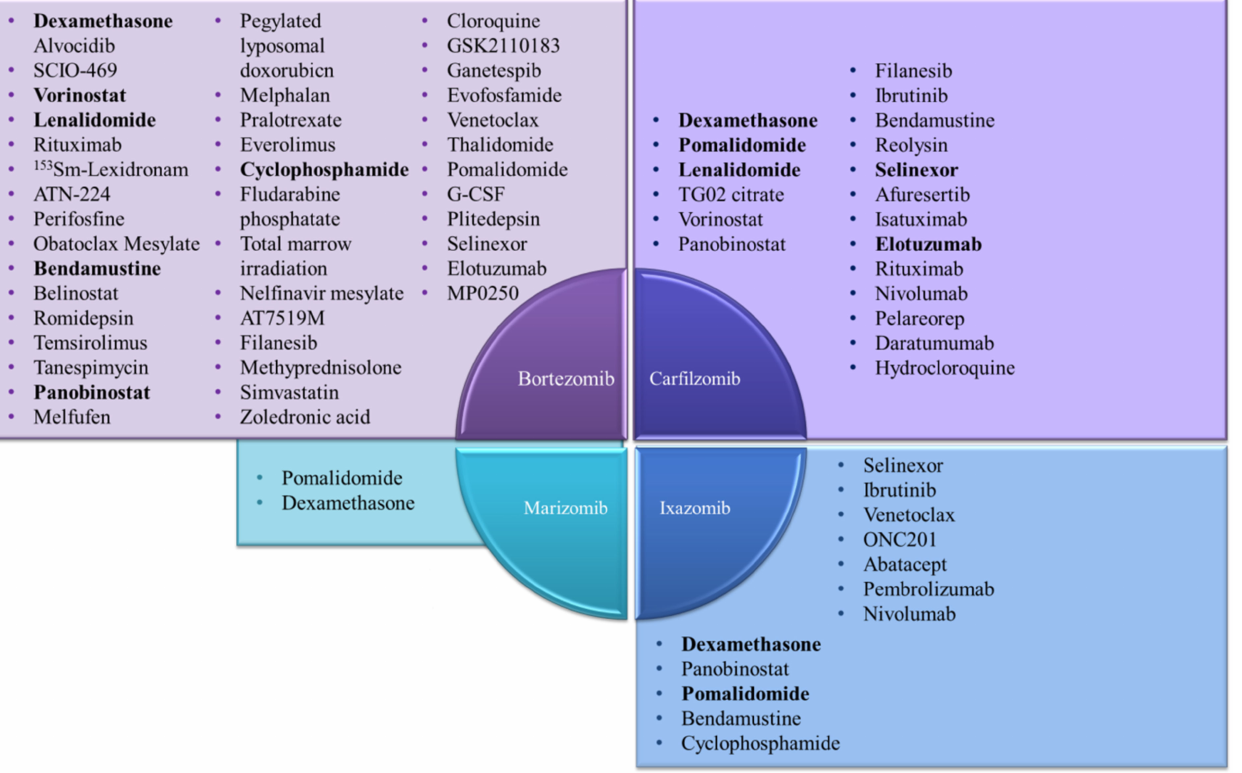
Figure 21. Combination therapies with 20S CP inhibitors in clinical trials, involving patients with relapsed and/or refractory disease, and who were previously treated with a 20S CP inhibitor (bold drugs are most frequently involved in combination therapy). Clinical trials were selected from ClinicalTrials (https://clinicaltrials.gov/ accessed on 22 February 2022), entering the search filter “bortezomib”, “carfilzomib”, “ixazomib”, “oprozomib”, “delanzomib” and “marizomib” in “other terms” fields, and sorted by study description, inclusion and exclusion criteria and